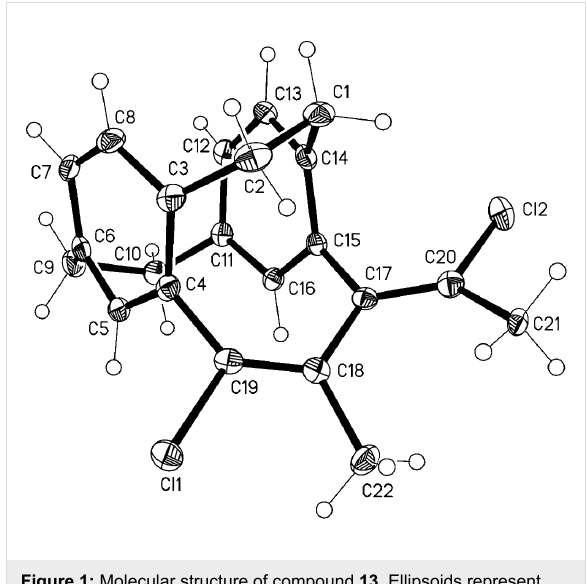
Figure 1: Molecular structure of compound 13 . Ellipsoids represent 50% probability levels. Selected molecular dimensions (Å, °):